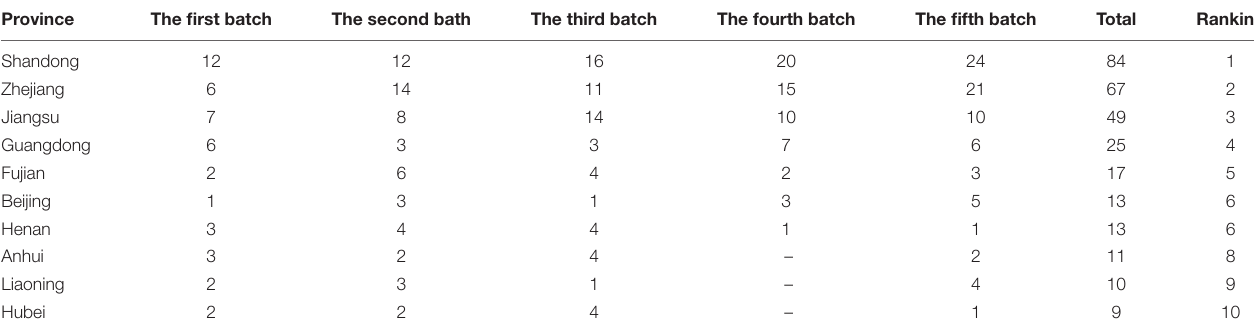
TABLE 1 | Top 10 provinces in the number of manufacturing single champion demonstration enterprises. Province